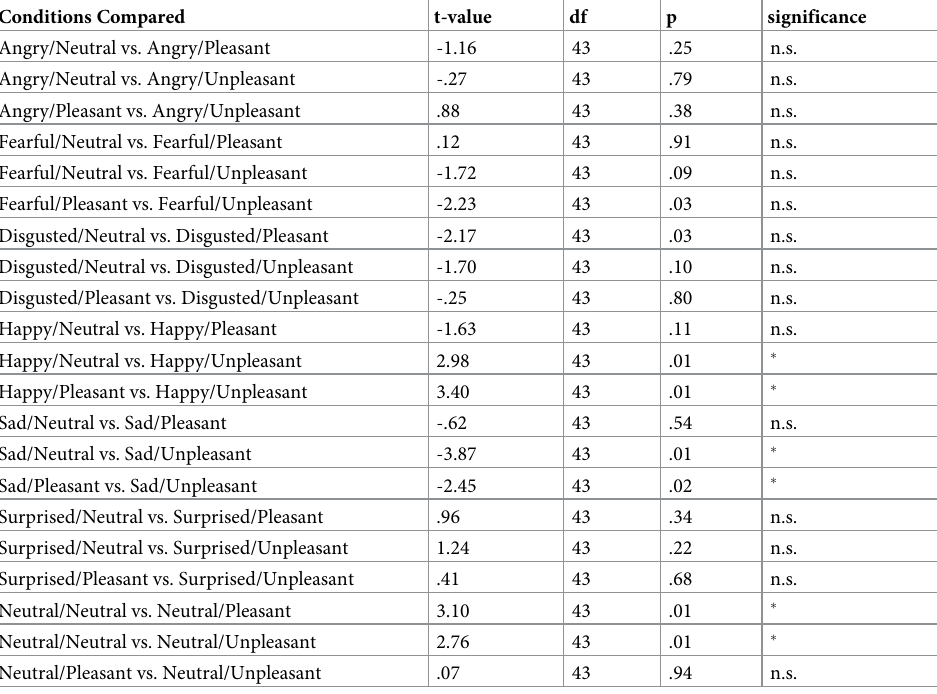
Table 2. Post-Hoc T-Test comparisons for the analysis of facial emotion labels. Conditions